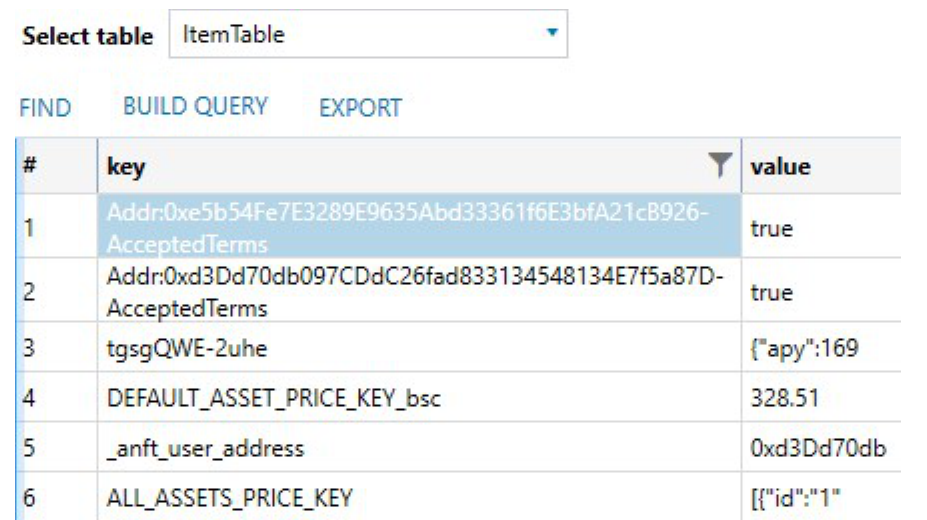
Figure 11. AirNFT service recovered information, which shows two wallet addresses that have accepted the terms of use.